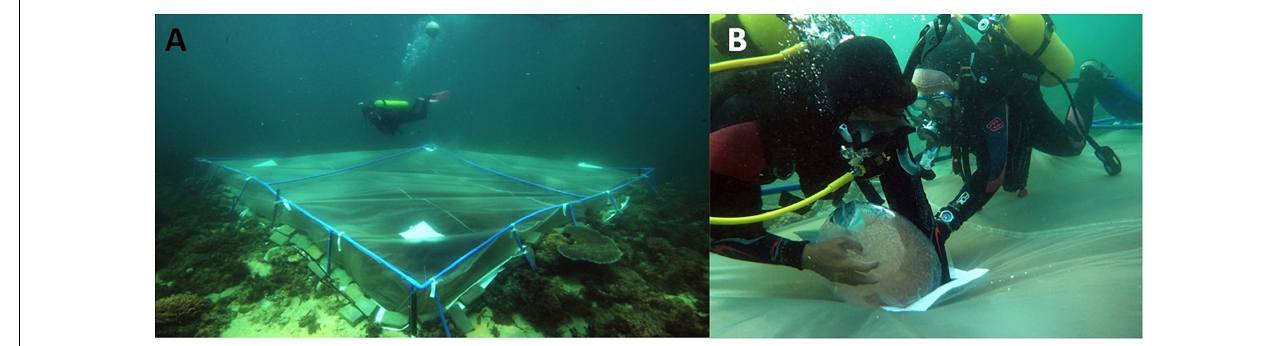
FIGURE 2 | Larval mesh tent enclosure with frame attached onto reef (A) , and divers adding concentrated A. tenuis larvae into a re-sealable portal on the mesh enclosure for settlement (B)